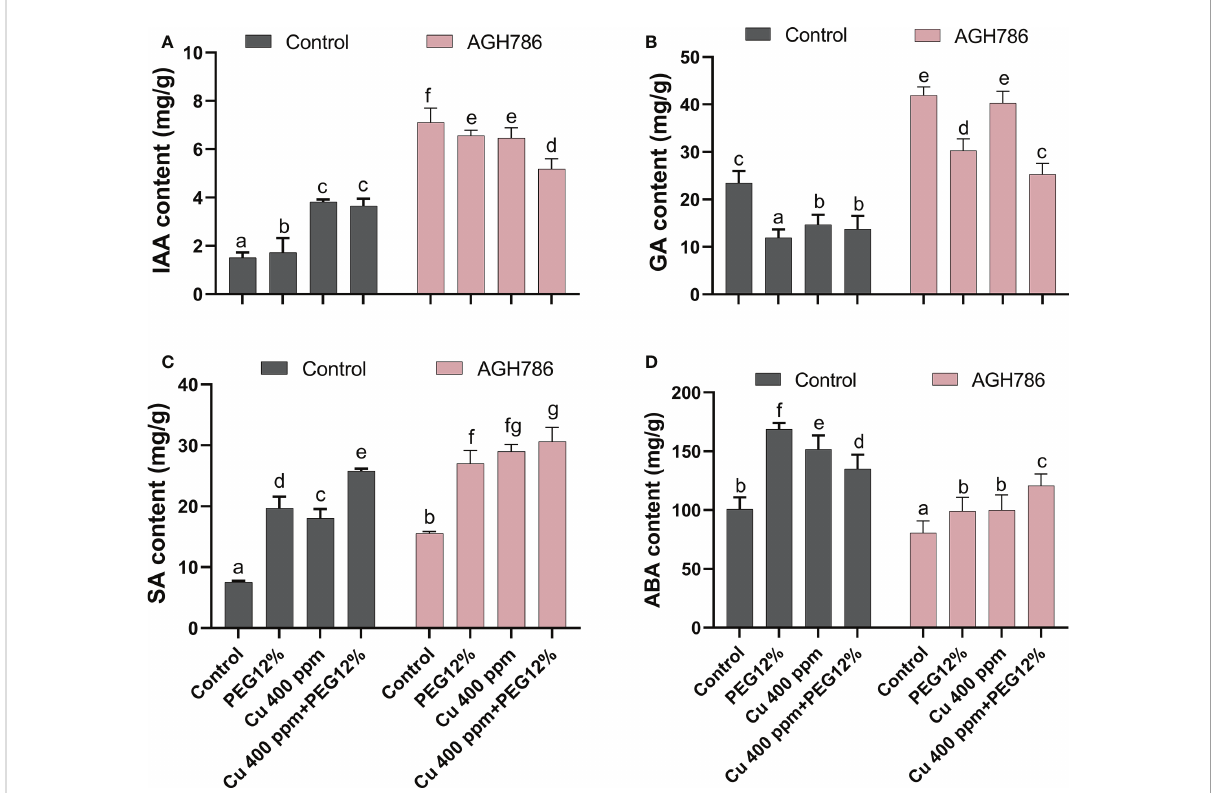
FIGURE 5 Effect of P. spadiceum AGH786 on hormonal content of S. lycopersicum L. under heavy metal (Cu) toxicity and drought stress (12% PEG). (A) Indole-3-acetic acid (IAA), (B) gibberellic acid (GA), (C) salicylic acid (SA), and (D) abscisic acid (ABA). Data represent the mean with standard error, and letters represent the signi fi cant difference (p <